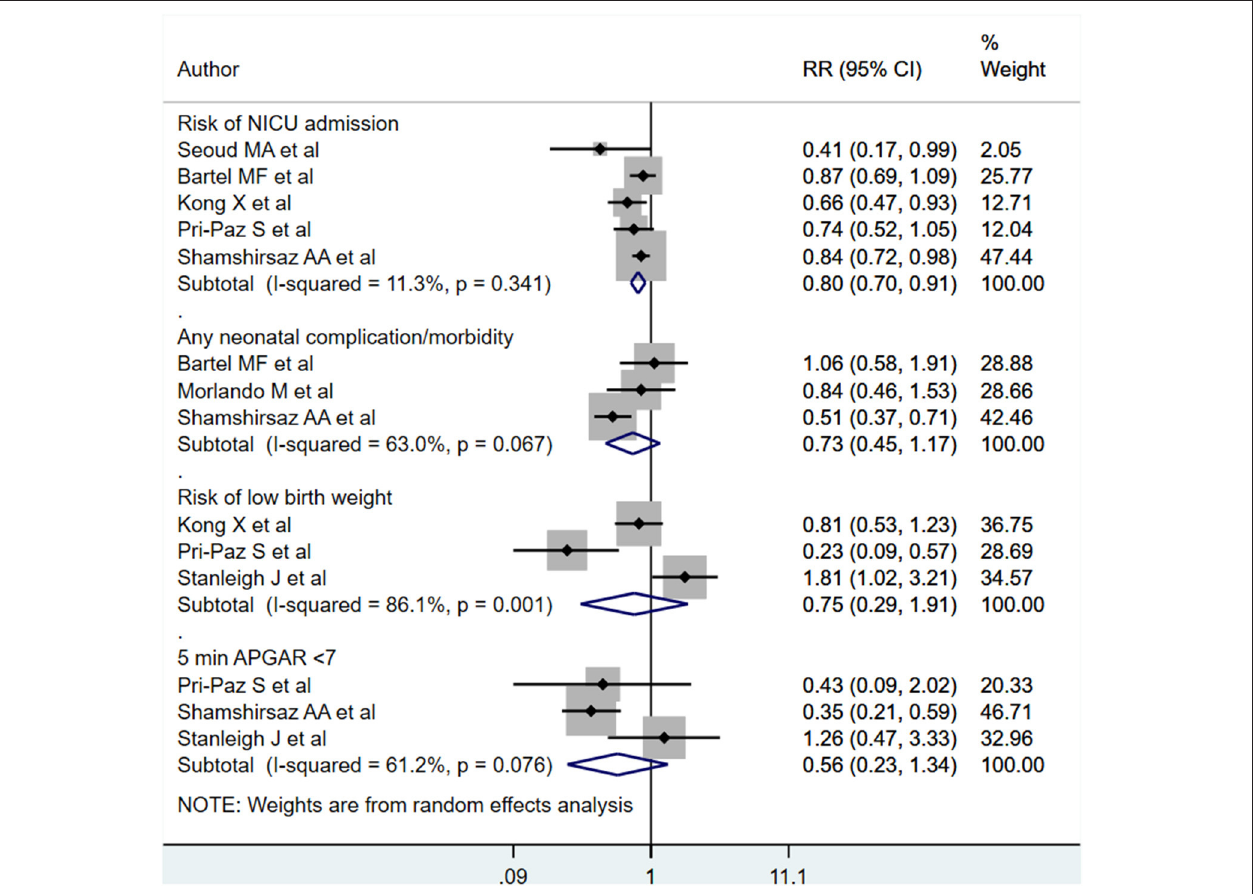
FIGURE 9 | Risk of NICU admission, neonatal complications, low birth weight, and low APGAR score for babies born to PAS patients via planned or emergency delivery.